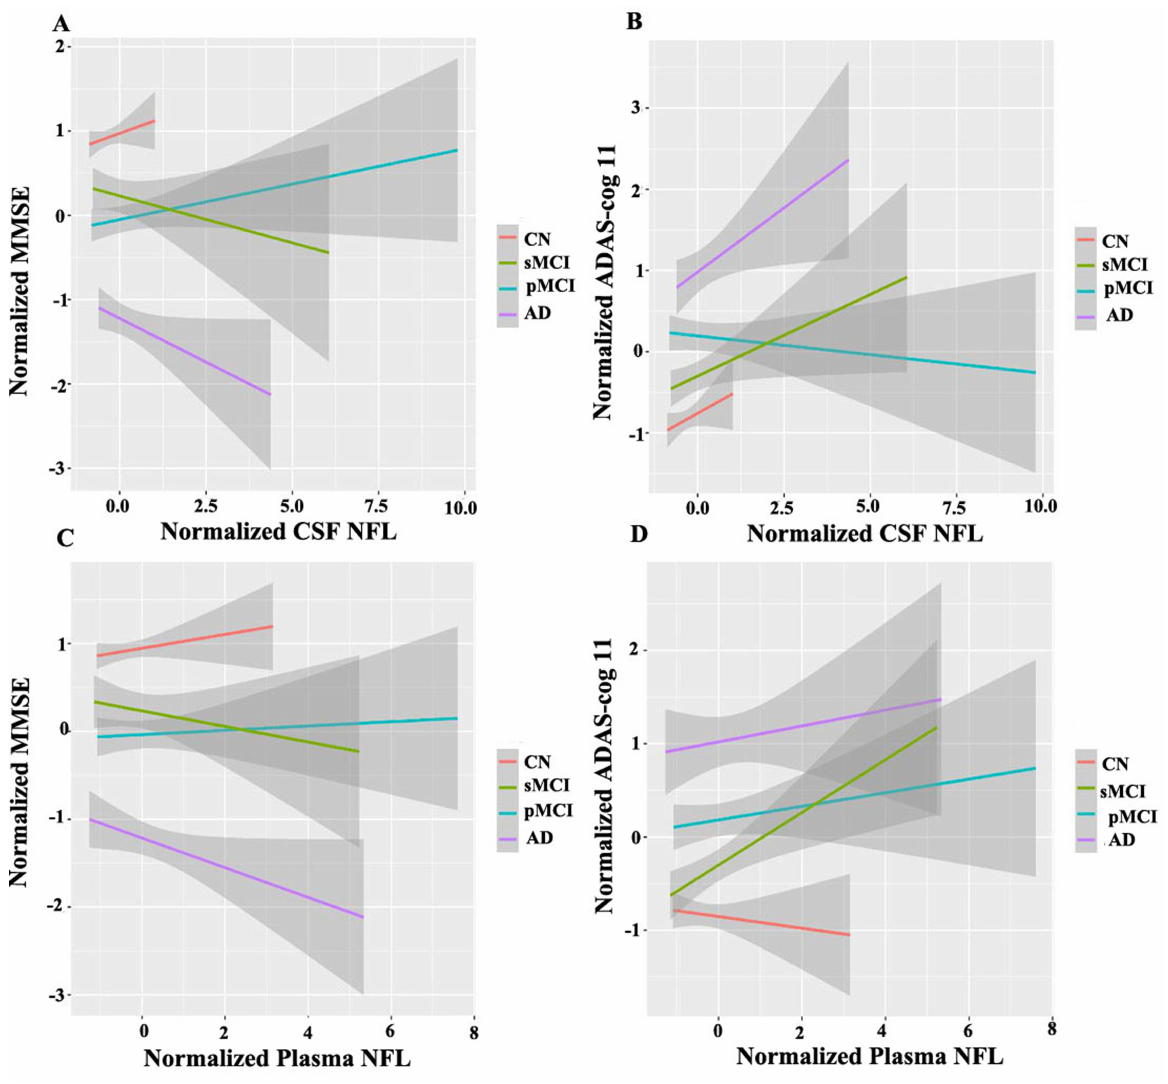
Fig.6. CSFandplasmaNFLinrelationtobaselinecognition. MMSE(A)andADAS-Cog(B)atbaselinefunctionasbaselineCSFNFLindifferentgroups. MMSE (C) and ADAS-Cog (D) at baseline function as baseline plasma NFL in different groups. Values of all indicators are